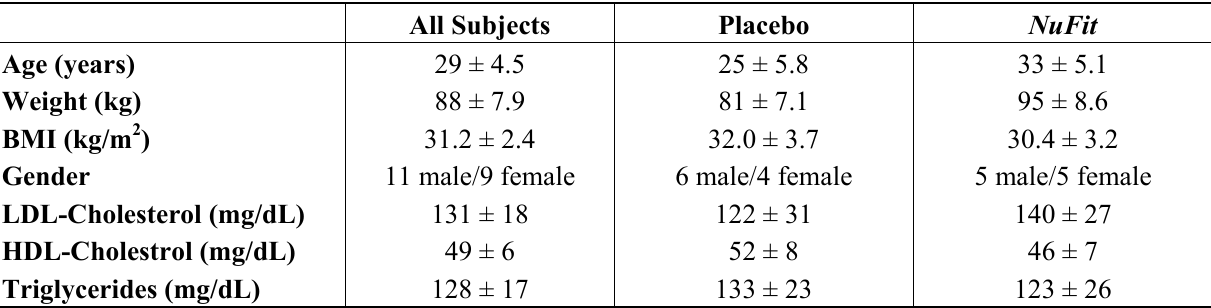
Table 2. Baseline subject